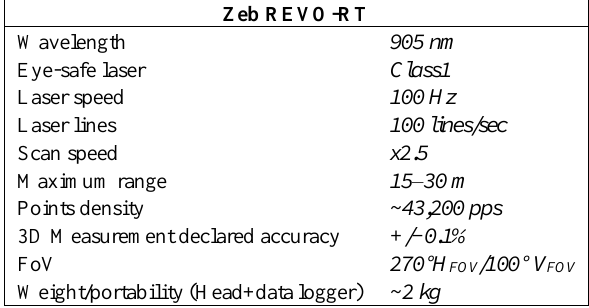
Table 1. Zeb REVO-RT portable scanner